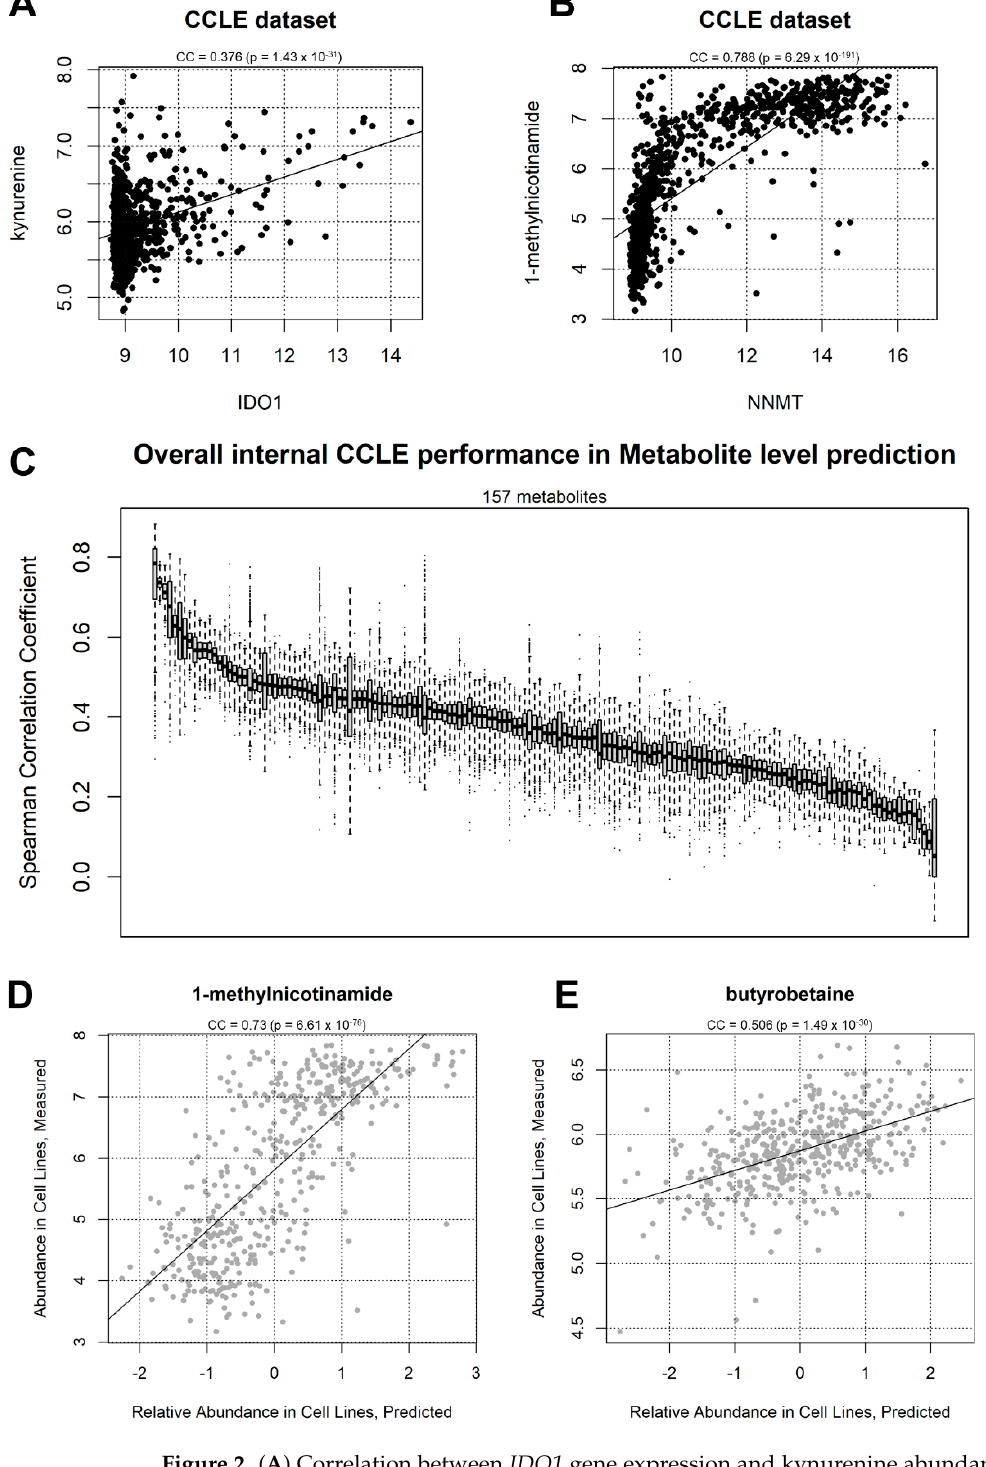
Figure 2. ( A ) Correlation between IDO1 gene expression and kynurenine abundance in the CCLE dataset. The Coefficient of Correlation (CC) and the associated p -value are indicated. ( B ) correlation between NNMT gene expression and 1-methylnicotinamed abundance in the CCLE dataset; ( C ) overall correlation coefficient distribution between real and predicted metabolite abundance value in 157 metabolites. Each boxplot represents a metabolite, sorted by average correlation, tested across 2000 CCLE partitions (50% of the data used as training and 50% as testing). ( D ) example correlation between 1-methylnicotinamide measured levels ( y -axis) and predicted levels according to corto -aggregated gene expression profiles ( x -axis). Each point represents a CCLE sample taken from 445 samples (50%) not used for metabolite-transcript network generation. The example represents an arbitrary split of the dataset into training and testing samples, providing a correlation coefficient